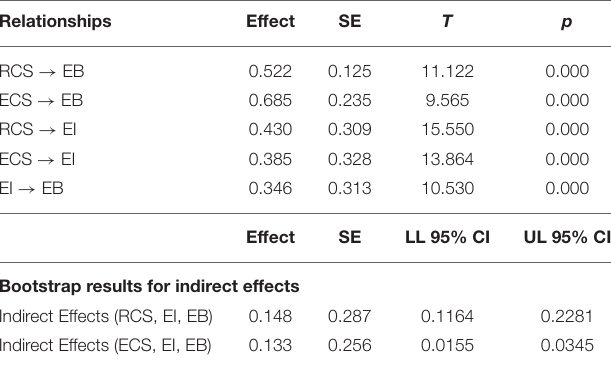
TABLE 3 | Mediated regression analysis